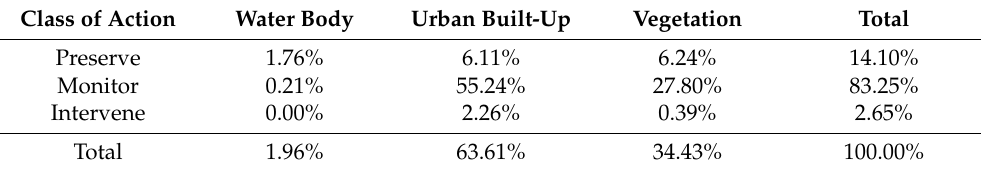
Table 14. Distribution of LULC per IUHI class of action based on NDVI. Class of Action